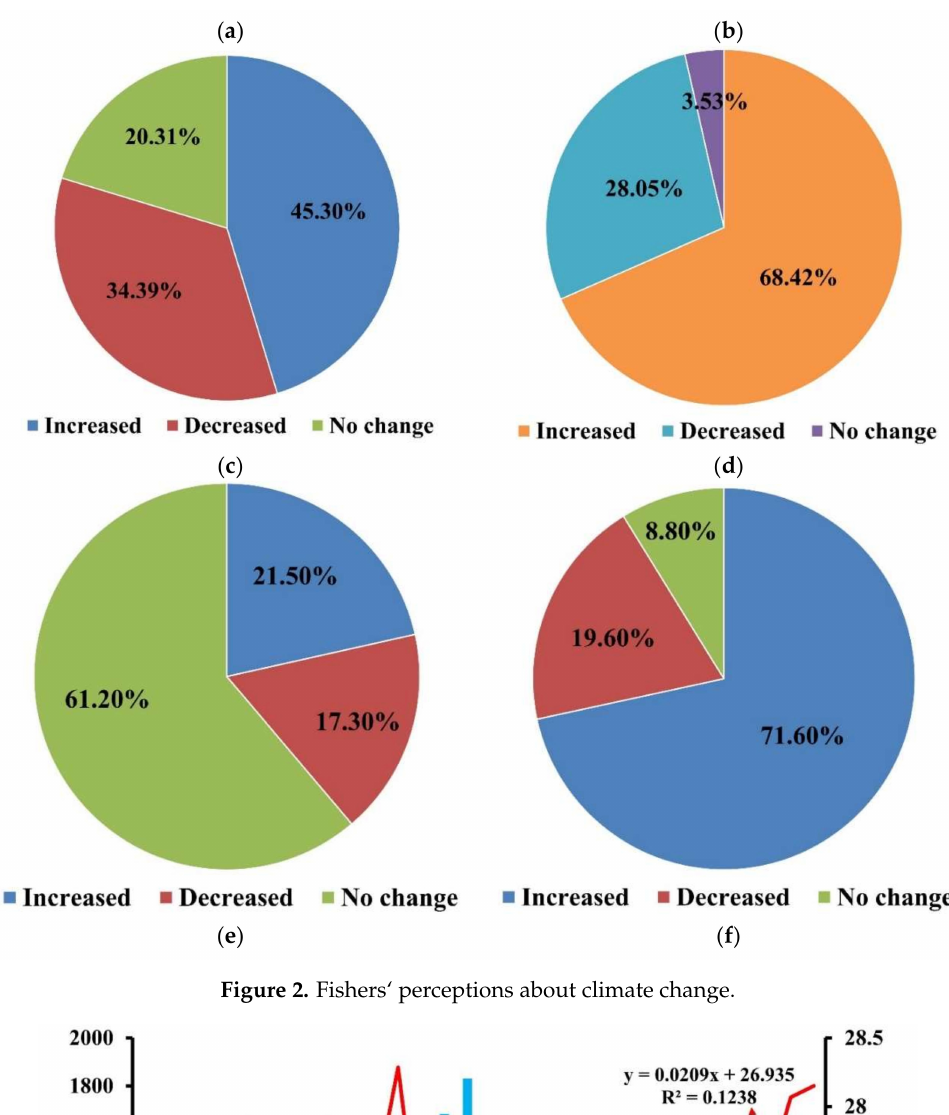
Figure 2. Fishers‘ perceptions about climate change.